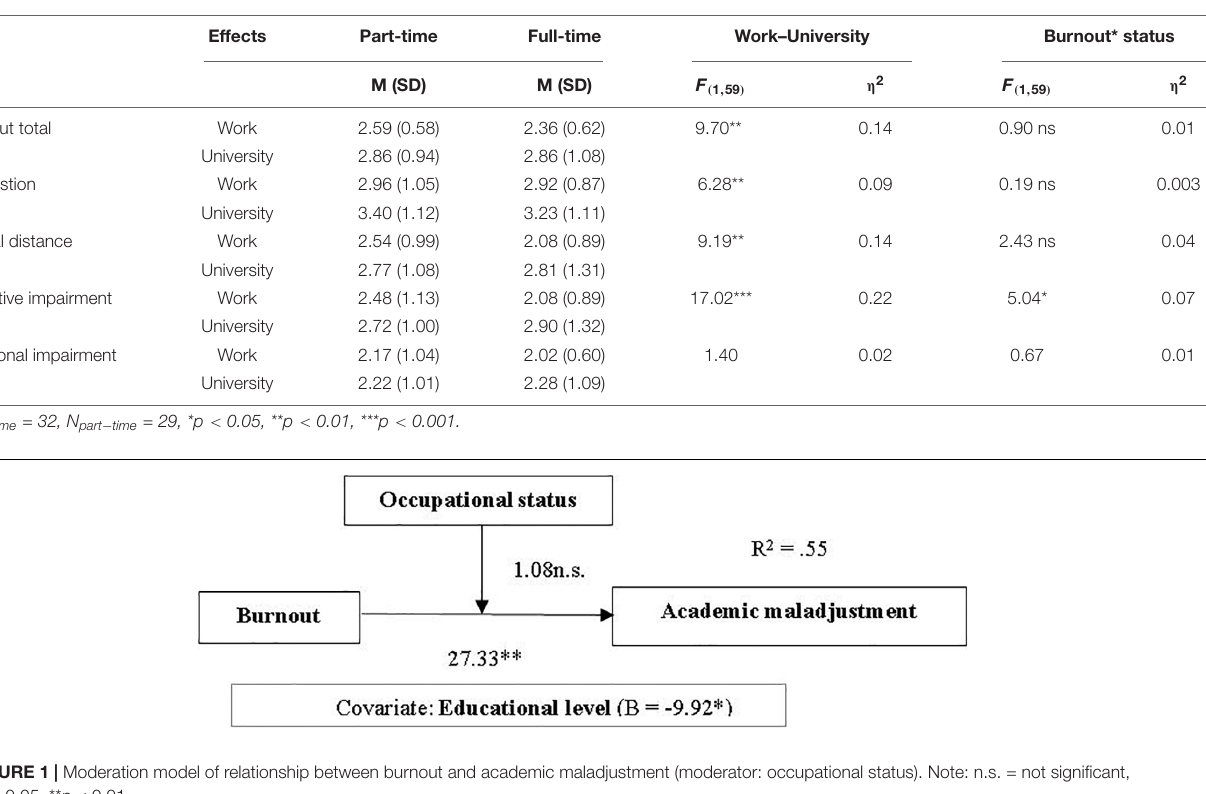
TABLE 1 | Differences between burnout levels in different contexts—Repeated-measures ANOVA.